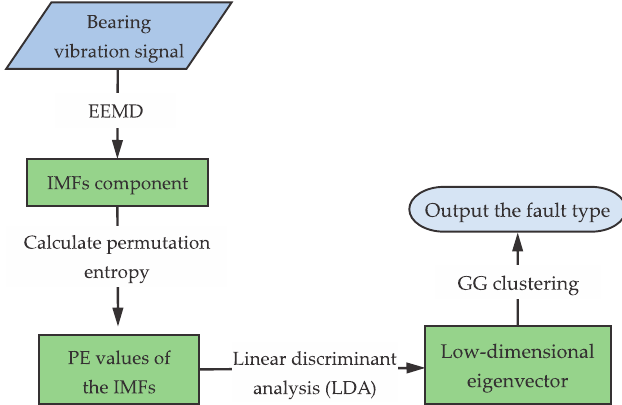
Figure 1. The flow chart of the fault classification method.